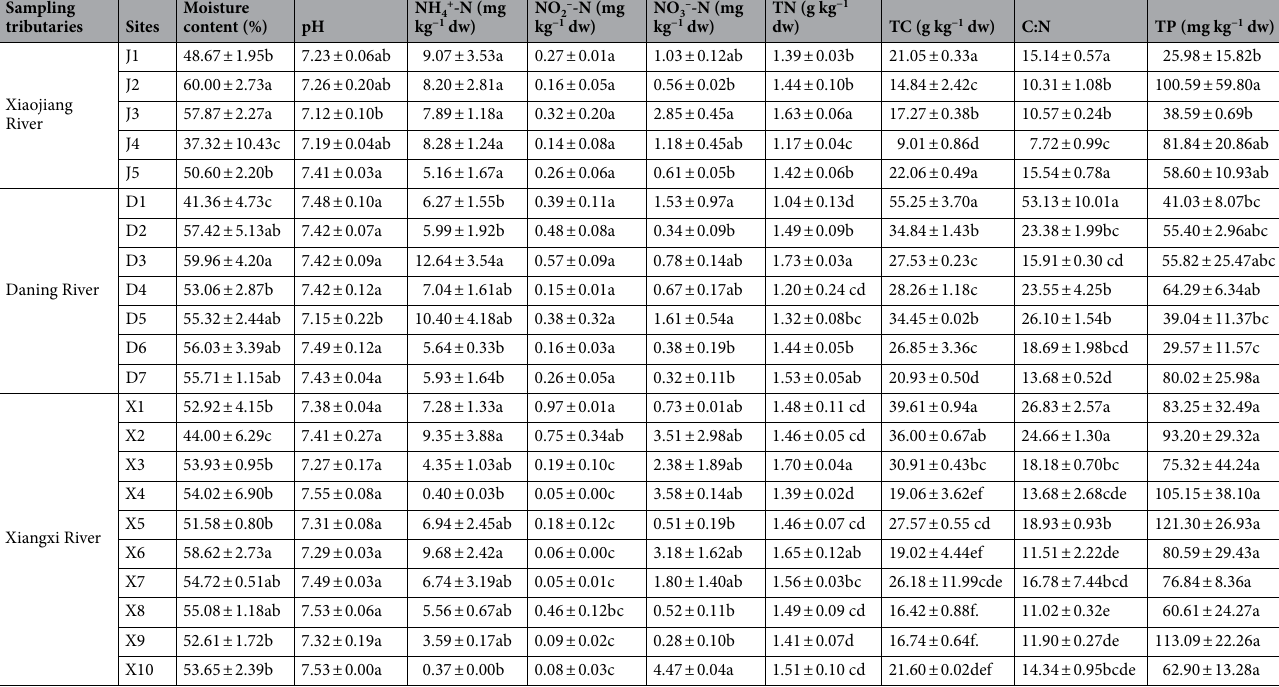
Table 1. Sediment physical and chemical properties for samples collected along the TGR typical tributaries. Different lower-case letters indicate a significant difference among different sites in the same tributary at the level of P < 0.05 by Duncan’